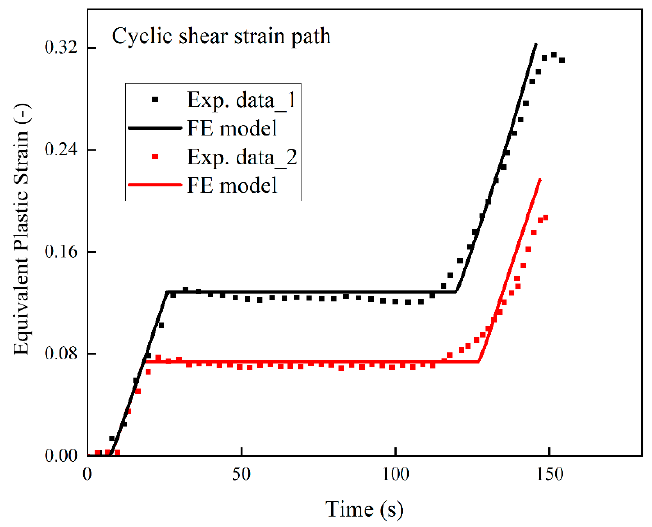
Figure 15. Schematic diagram of the twin bridge torsion shear specimen: ( a ) CAD model; ( b ) the simplified FE model.